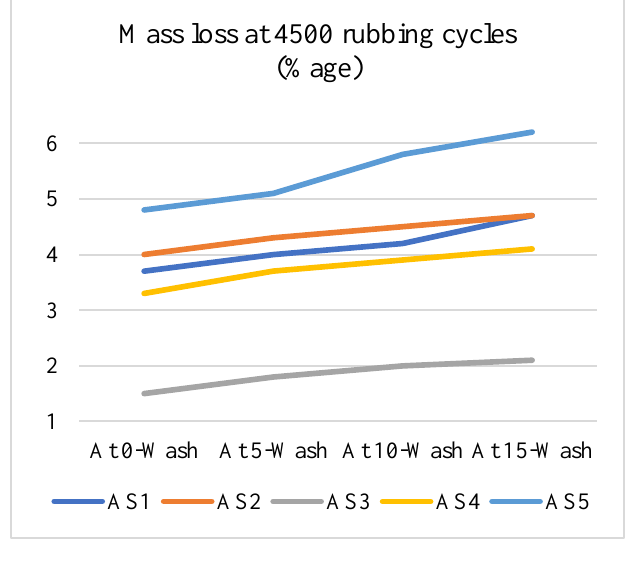
Fig. 3. Mass loss at 4500 rubbing cycles at various washing intervals